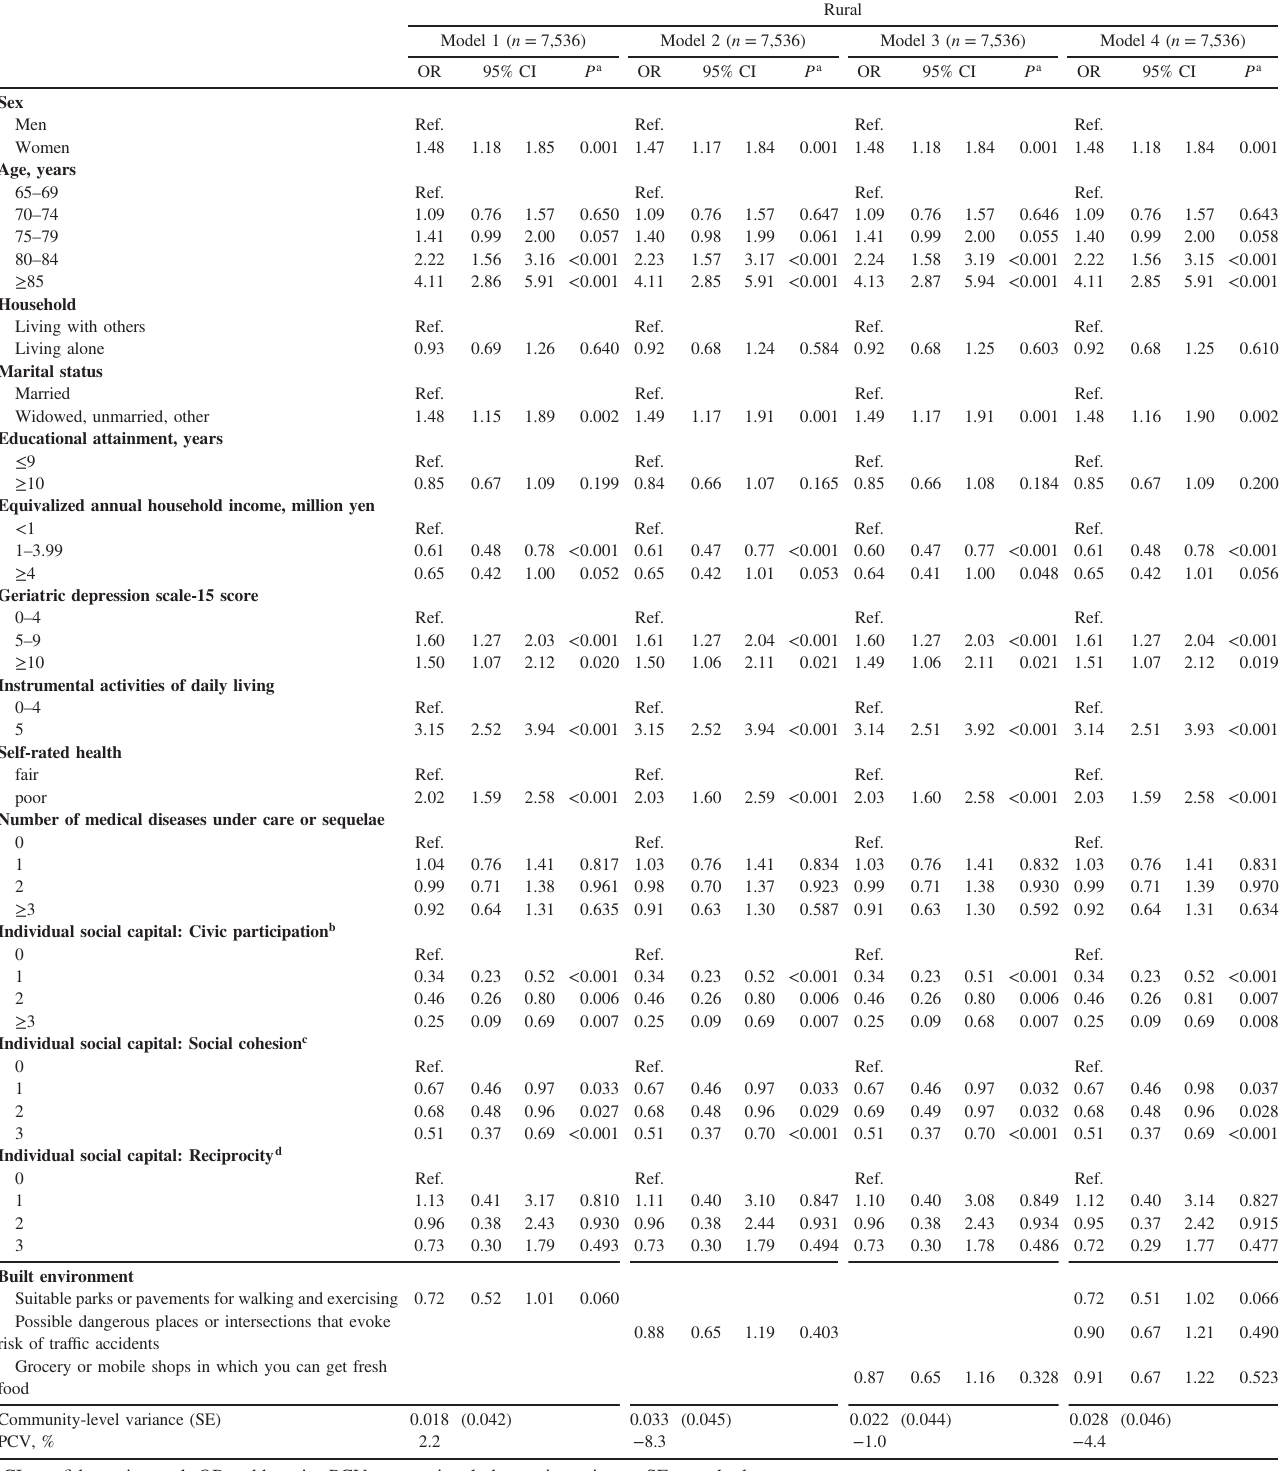
Table 4A. Result of multilevel logistic regression analysis to examine the association between neighborhood built environment and homebound status in rural